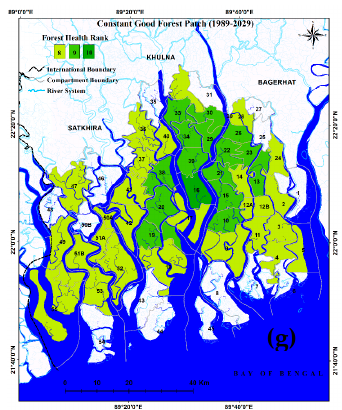
Figure 8. Spatial forest health quality assessment from 1989–2029. ( a ) SFHQ status of 1989, ( b ) SFHQ status of 1999, ( c ) SFHQ status of 2009, ( d ) SFHQ status of 2014, ( e ) SFHQ status of 2019, ( f ) future SFHQ status of 2029, ( g ) overall CGP forest in SRF (1989–2029). Note: FC numbers is labeled with black bold numbers.